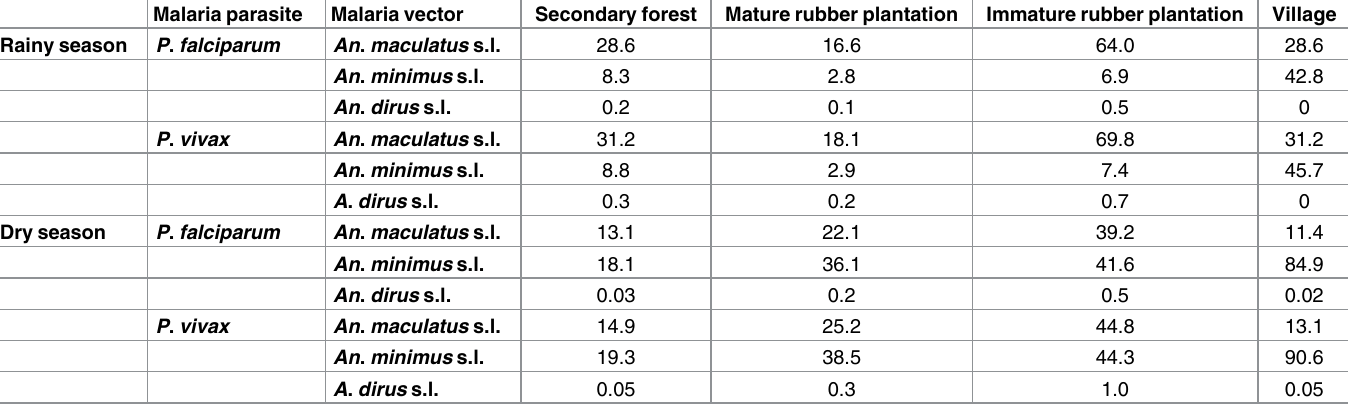
Table 5. The basic reproductive number for P . falciparum and P . vivax malaria parasitescalculated for the different vectorsin the different habitats during the rainy season and dry season. Malaria